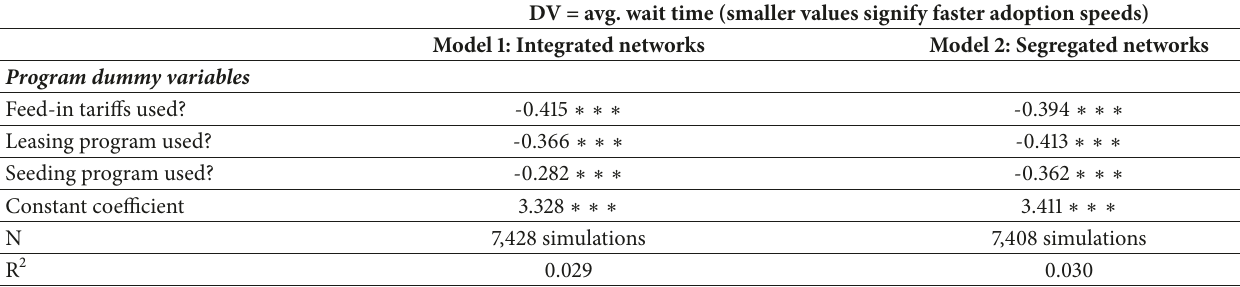
Table 3: Effect of incentive programs on speed of adoption: integrated versus segregated social networks. DV = avg. wait time (smaller values signify faster adoption speeds) Model 1: Integrated